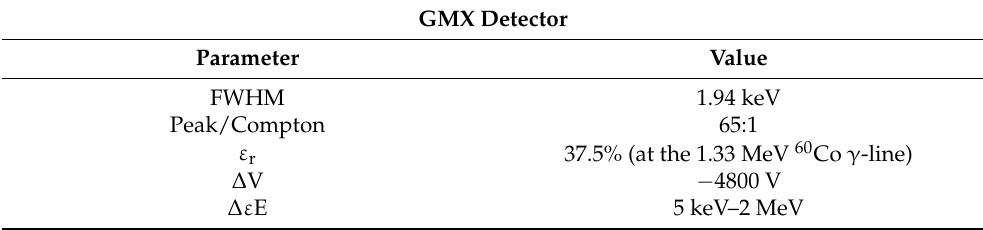
Table 2. The GMX